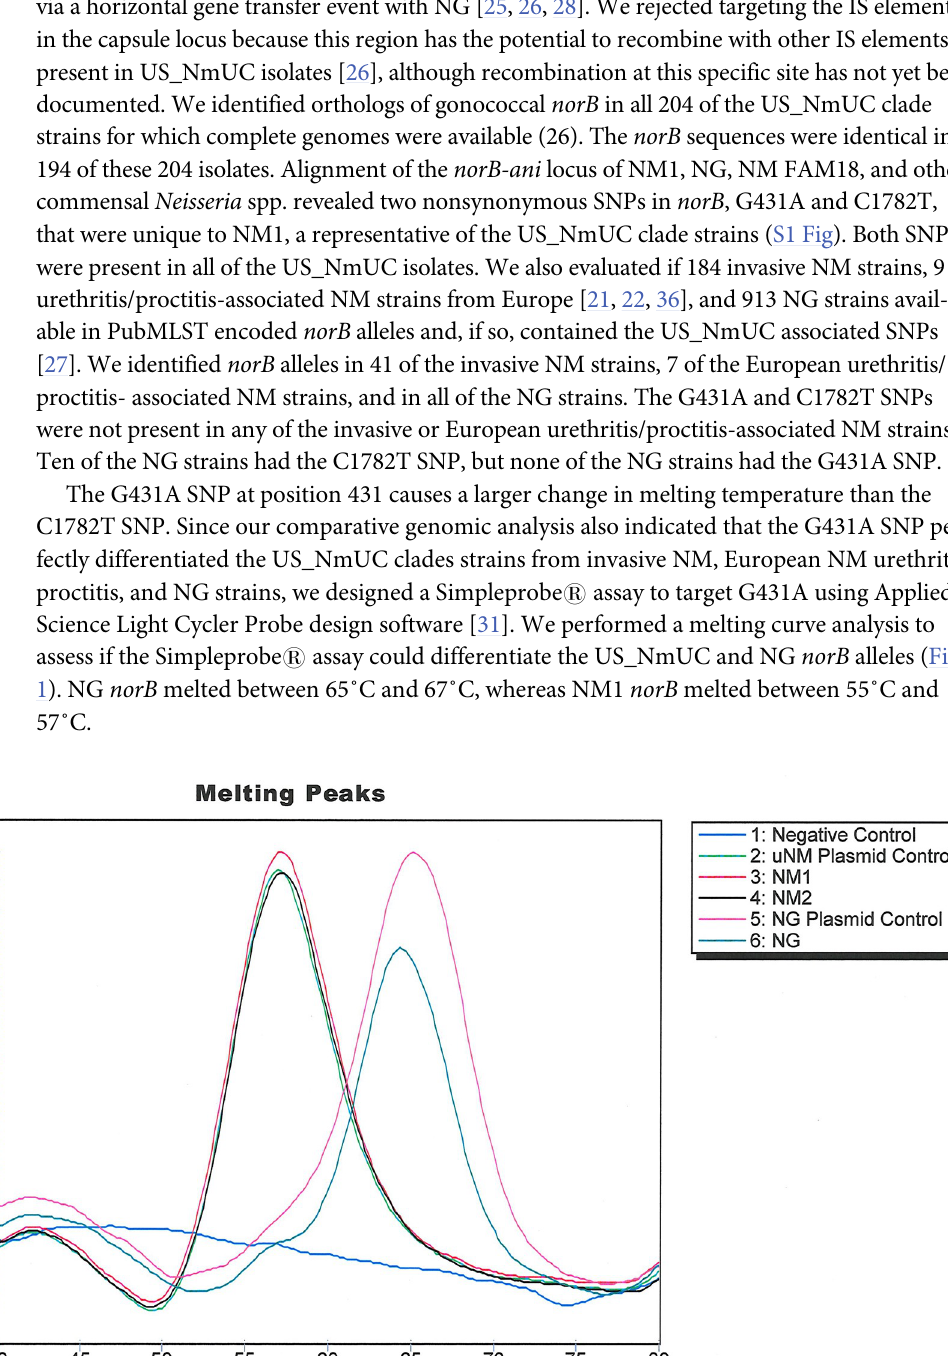
PLOS ONE | https://doi.org/10.1371/journal.pone.0228467 February 10,